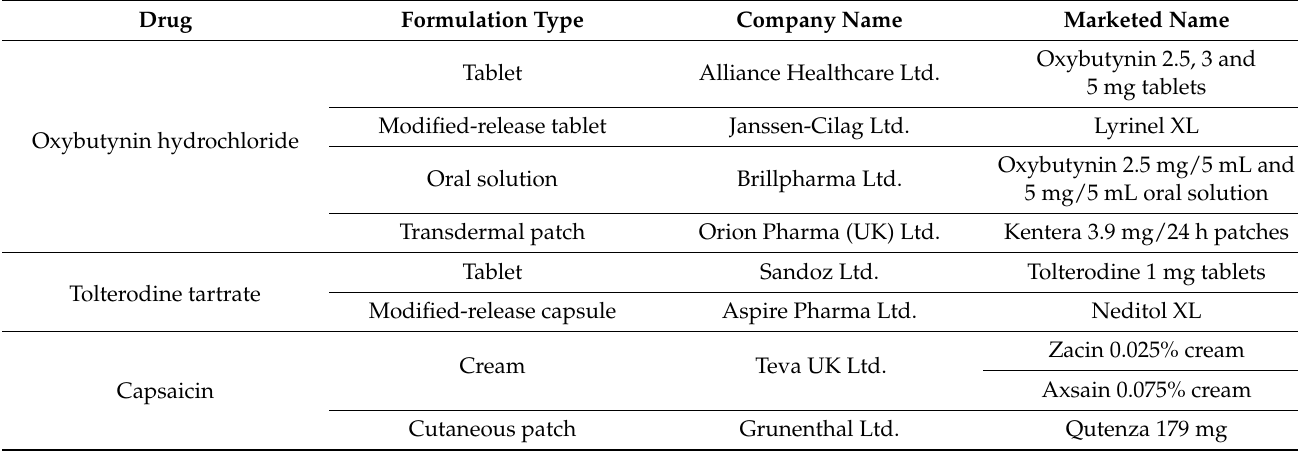
Figure 4. Risk of bias assessment of eligible articles. Table 2. List of commercial products of drugs used for managing OAB